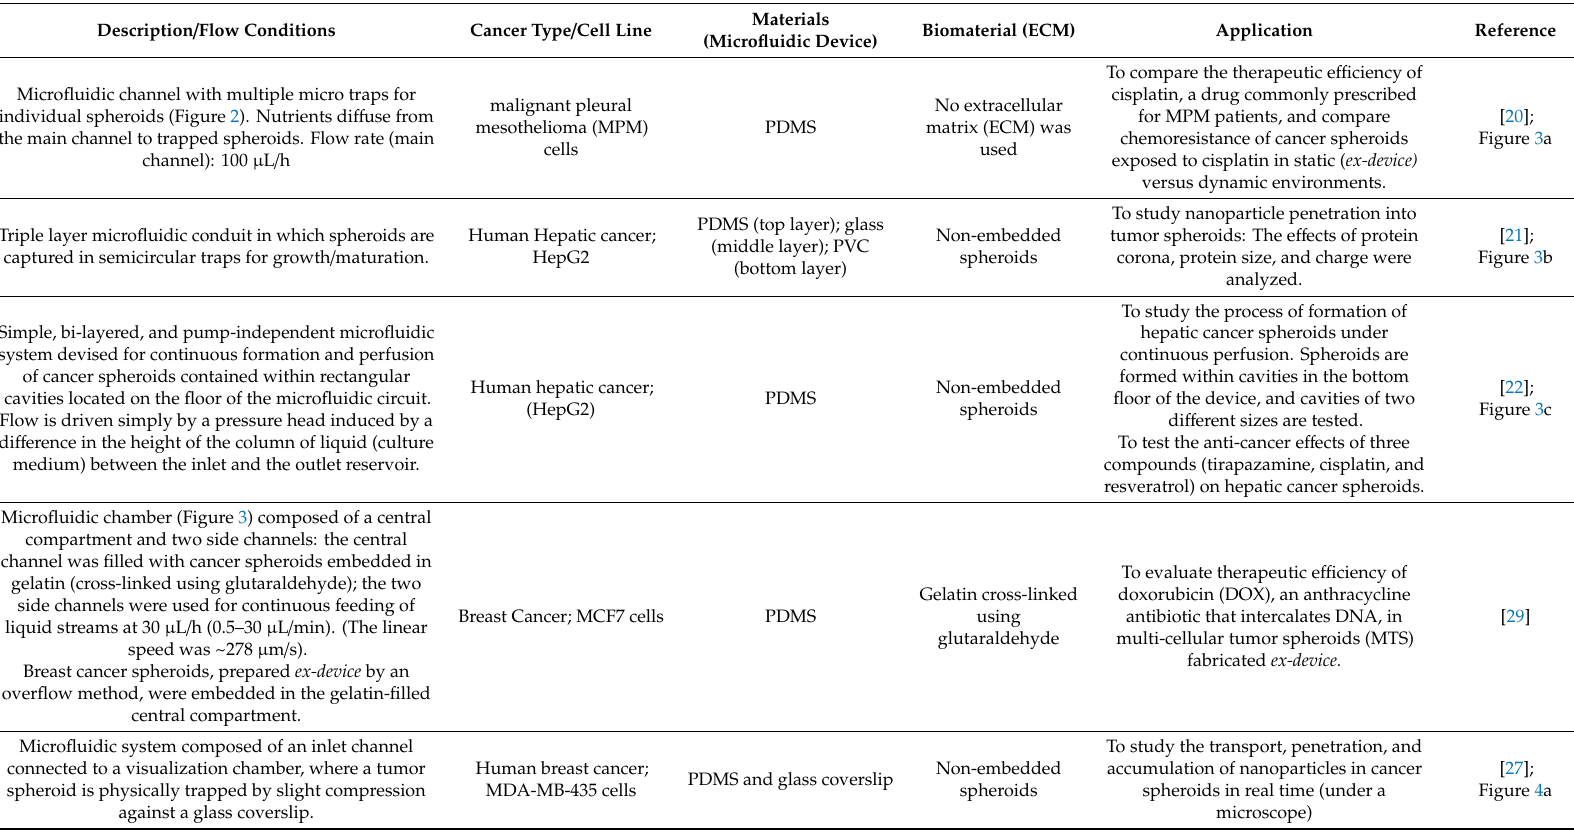
Table 1. Summary of a selection of recently published research papers (2013–2019) on tumor-on-chip